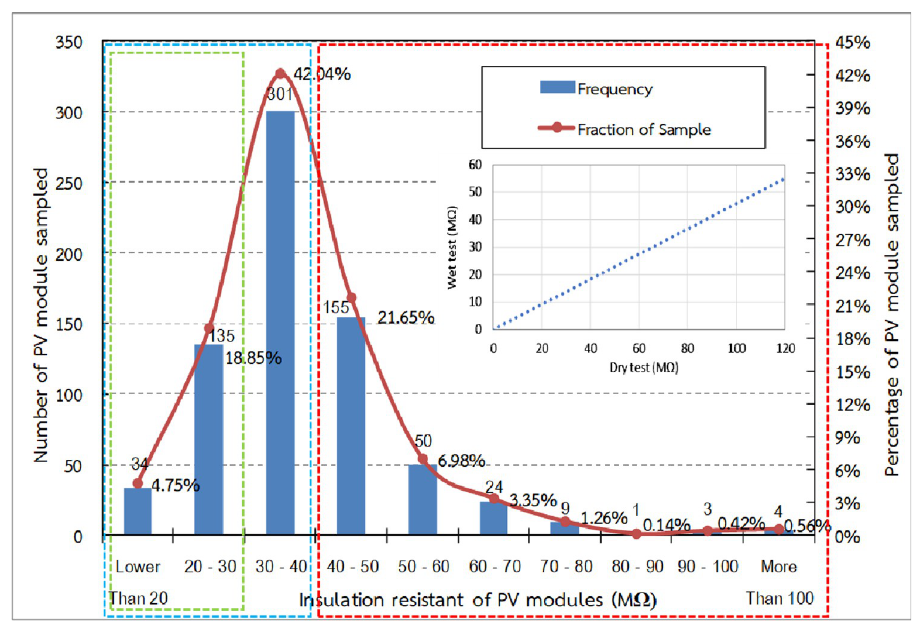
Fig 10. Insulation resistance of wet sampled PV